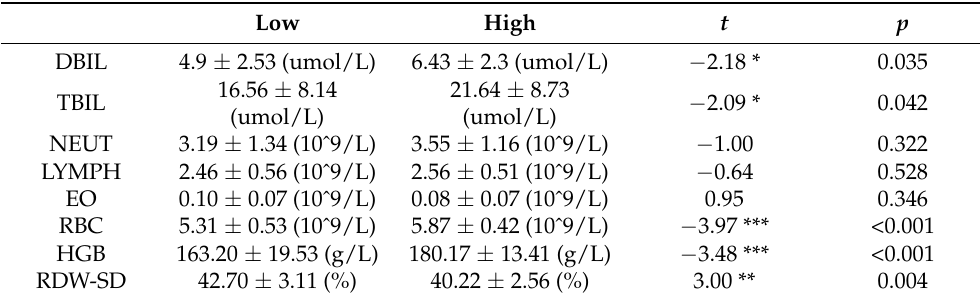
Table 2. Statistical values of the independent sample T test for biochemical indexes in the low- and high-CRF groups (mean ± SD).